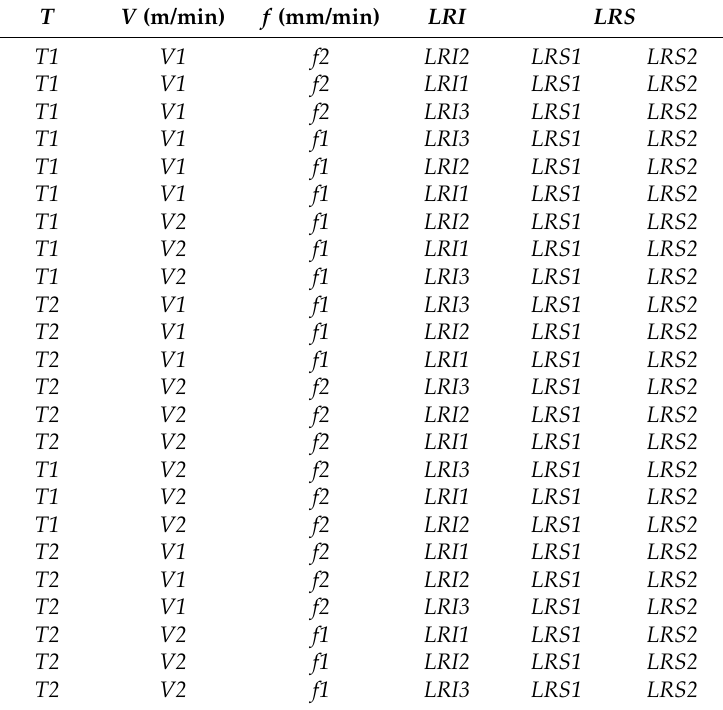
Table 2. Experimental design: product of a full factorial 2 3 and a block of two factors 3 ×